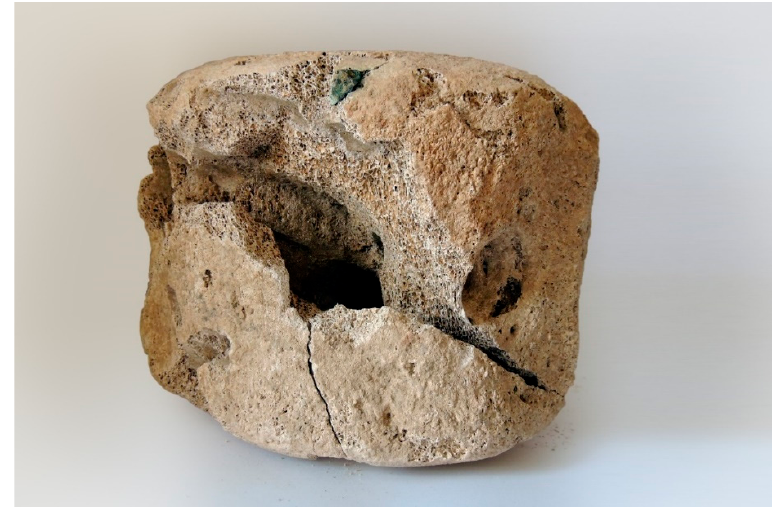
Figure 27. One of the sperm whale vertebrae, with a bronze spearpoint (MGW inv. no. 3263), from the “Place of Cremation”, on display at the Whitaker Museum.